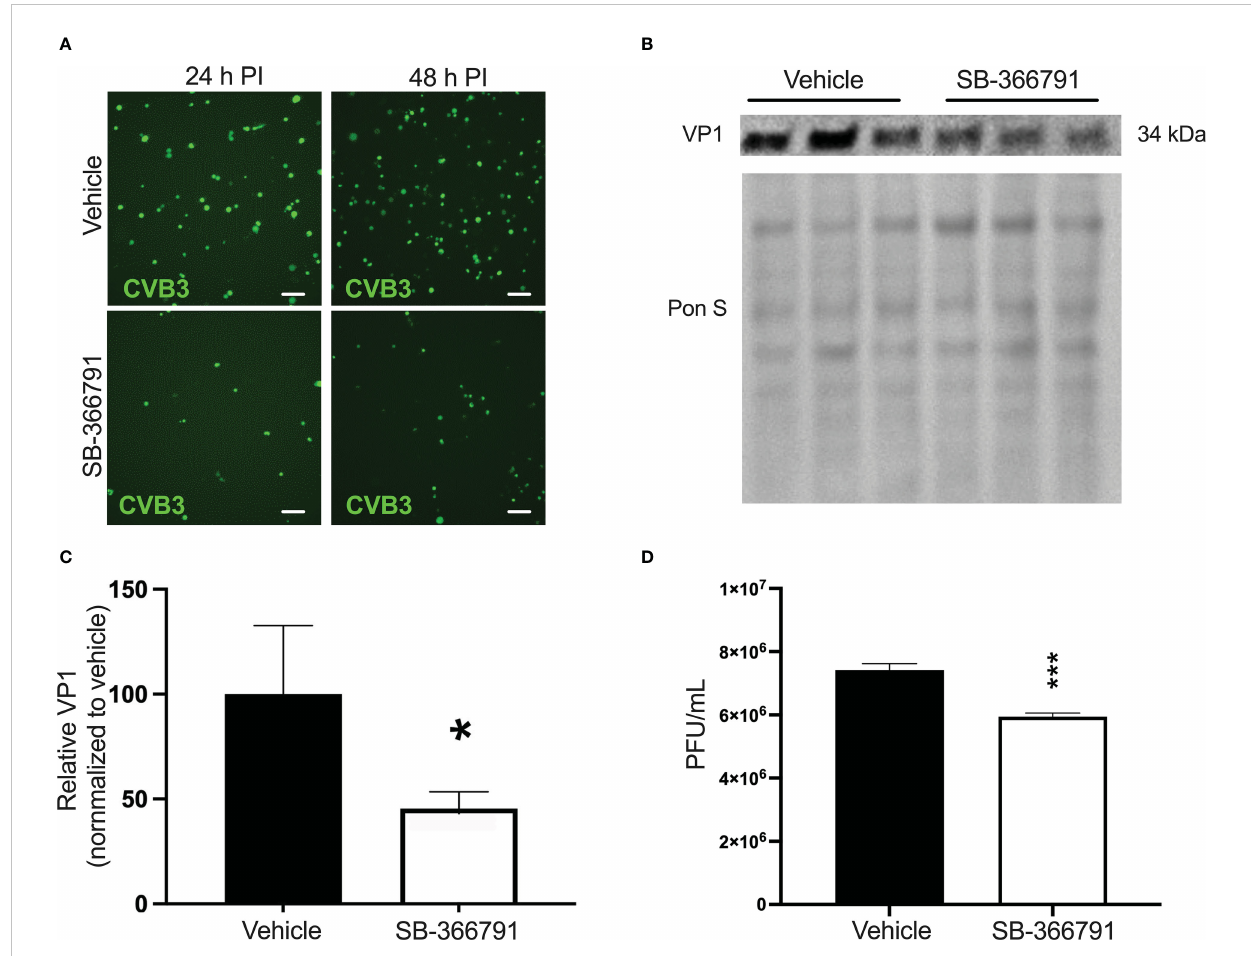
FIGURE 4 Treatment with SB-366791 inhibits CVB3 infection in iBECs iBECs were pretreated with 10 µM SB-366791 or DMSO (vehicle) for 24 h prior to infecting with eGFP-CVB3 at MOI 10. (A) Fluorescence microscopy images detecting viral eGFP at indicated timepoints. Scale bars= 100 µm. (B) Western blot detecting viral capsid protein VP1 in iBEC lysates from cells in A 48 h PI. Ponceau S staining of the membrane is shown below. (C) Densitometric quanti fi cation of B normalized to background intensity 48 h PI. (D) Plaque assay quanti fi cation of infectious viral titers of media from iBECs (*p<0.05, ***p<0.001; student ’ s t -test; n=3. Error bars represent standard